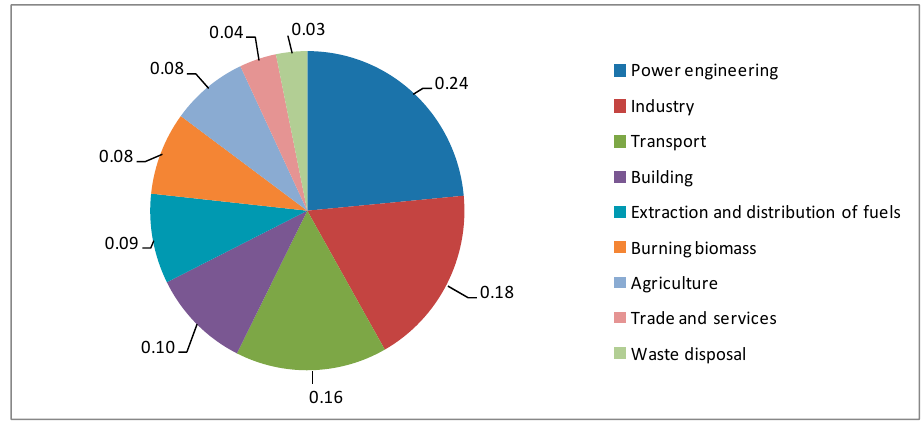
Figure 9. Sources of greenhouse gas emissions by sectors of the economy in 2019 [56].